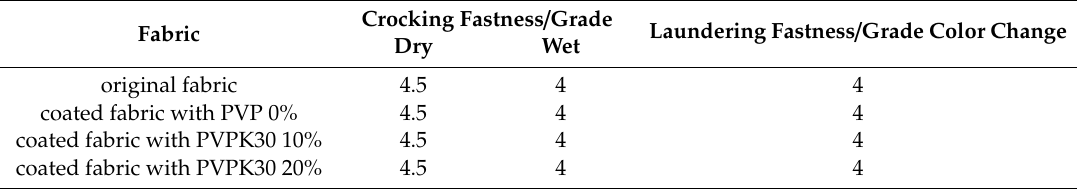
Table 4. Comparison of the fastness of coated fabric with di ff erent